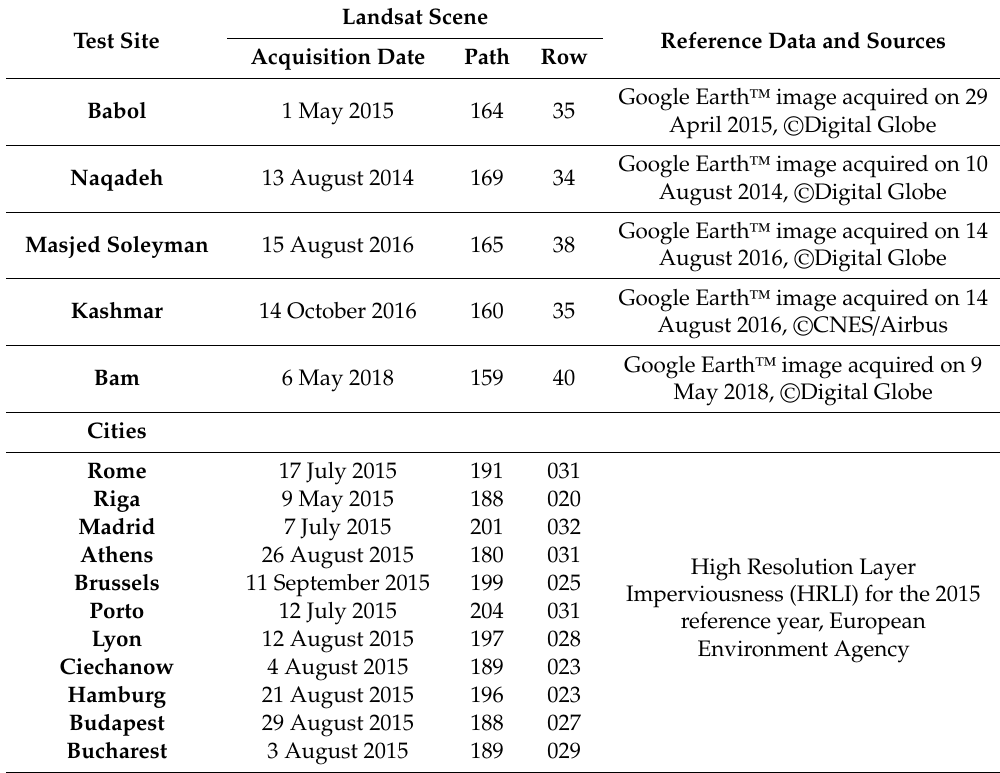
Table 2. Description of the Landsat 8 OLI scenes and corresponding reference